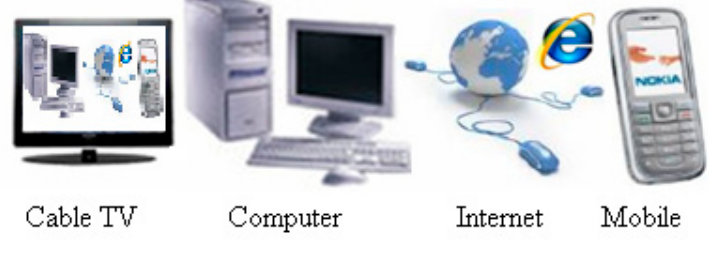
Figure 1. Implements of cyberspace.